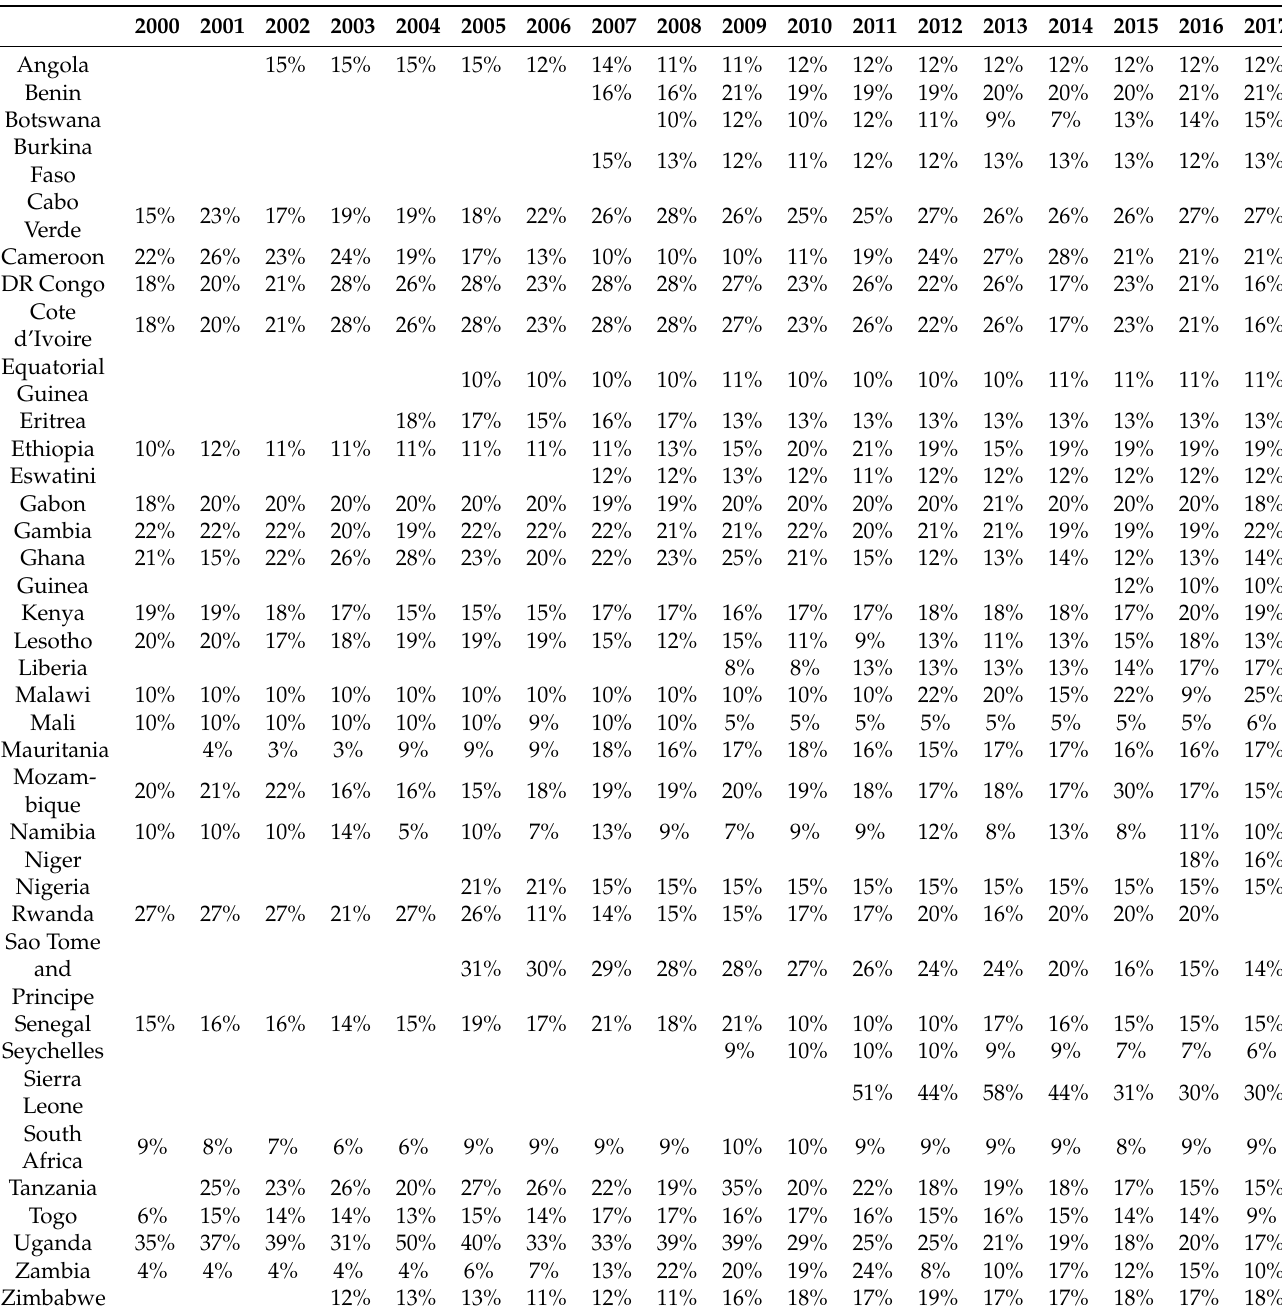
Table A4. Technical network losses of sub-Saharan African countries from 2000 to